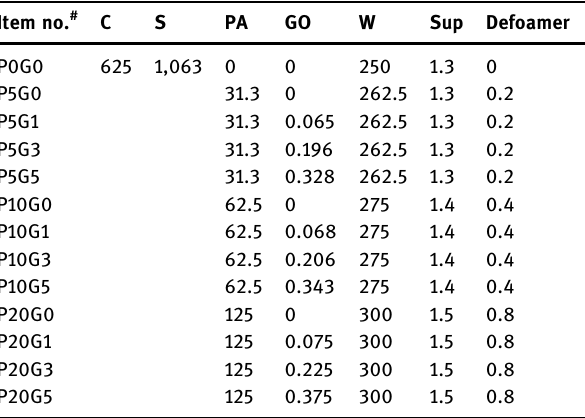
Table 3: Experimental mix ratio design of GOPARMs ( unit: kg/m 3 )